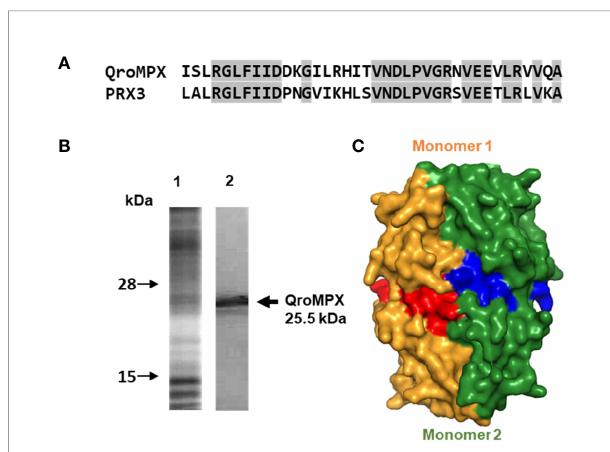
FIGURE 3 | Recognition of QroMPX by anti-human PRX3 antibody. (A) Shared sequence between QroMPX and PRX3 recognized by a commercial antibody. Identical amino acids are shaded. (B) Western blot was performed as indicated in materials and methods. The total parasite protein transferred (lane 1, Coomassie Blue stain) and the recognition of QroMPX by the commercial anti-PRX antibody (lane 2). (C) Model showing the regions on the surface of each QroMPX monomer (red and blue) that can be recognized by the antibody.